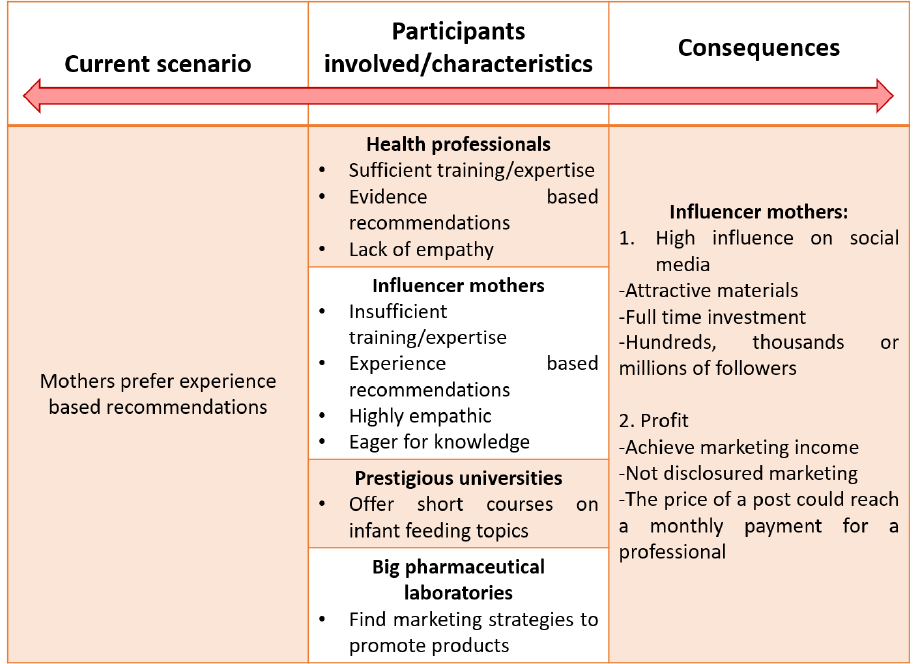
Figure 3. Causes, consequences and actors involved with influencer